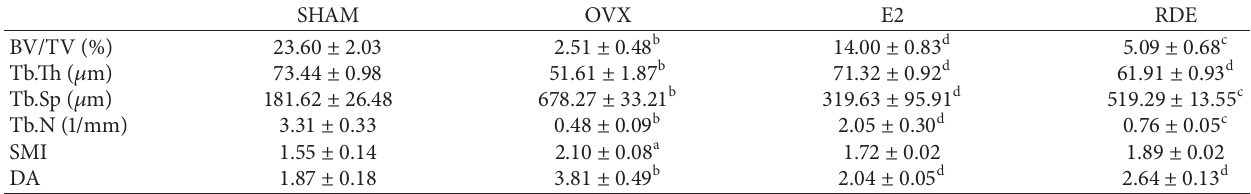
Table 4: Effect of RDE on trabecular bone microarchitecture after 12 weeks of treatment. SHAM